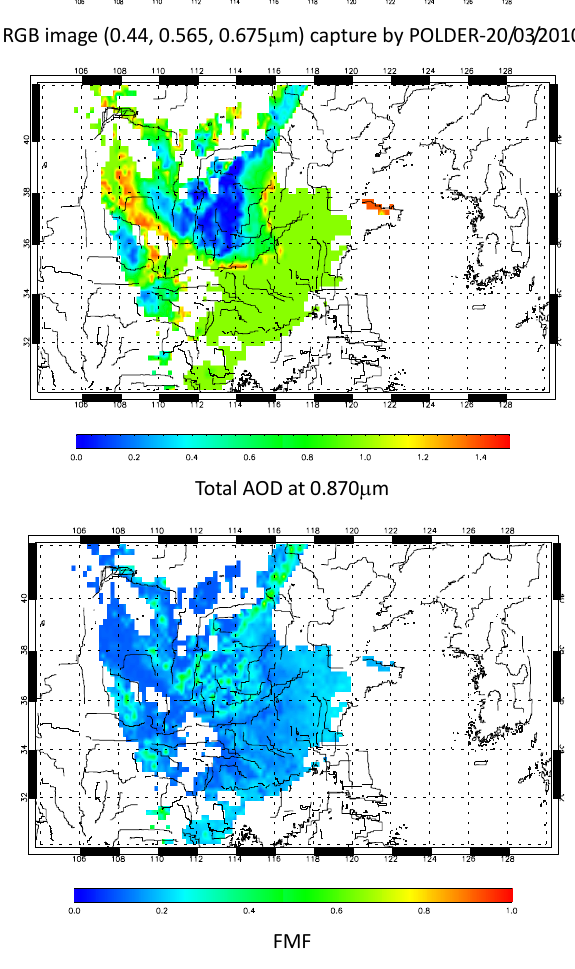
Fig. 3. Retrieved products from multi-angular, multi-spectral, total and polarized measurements on 20 March